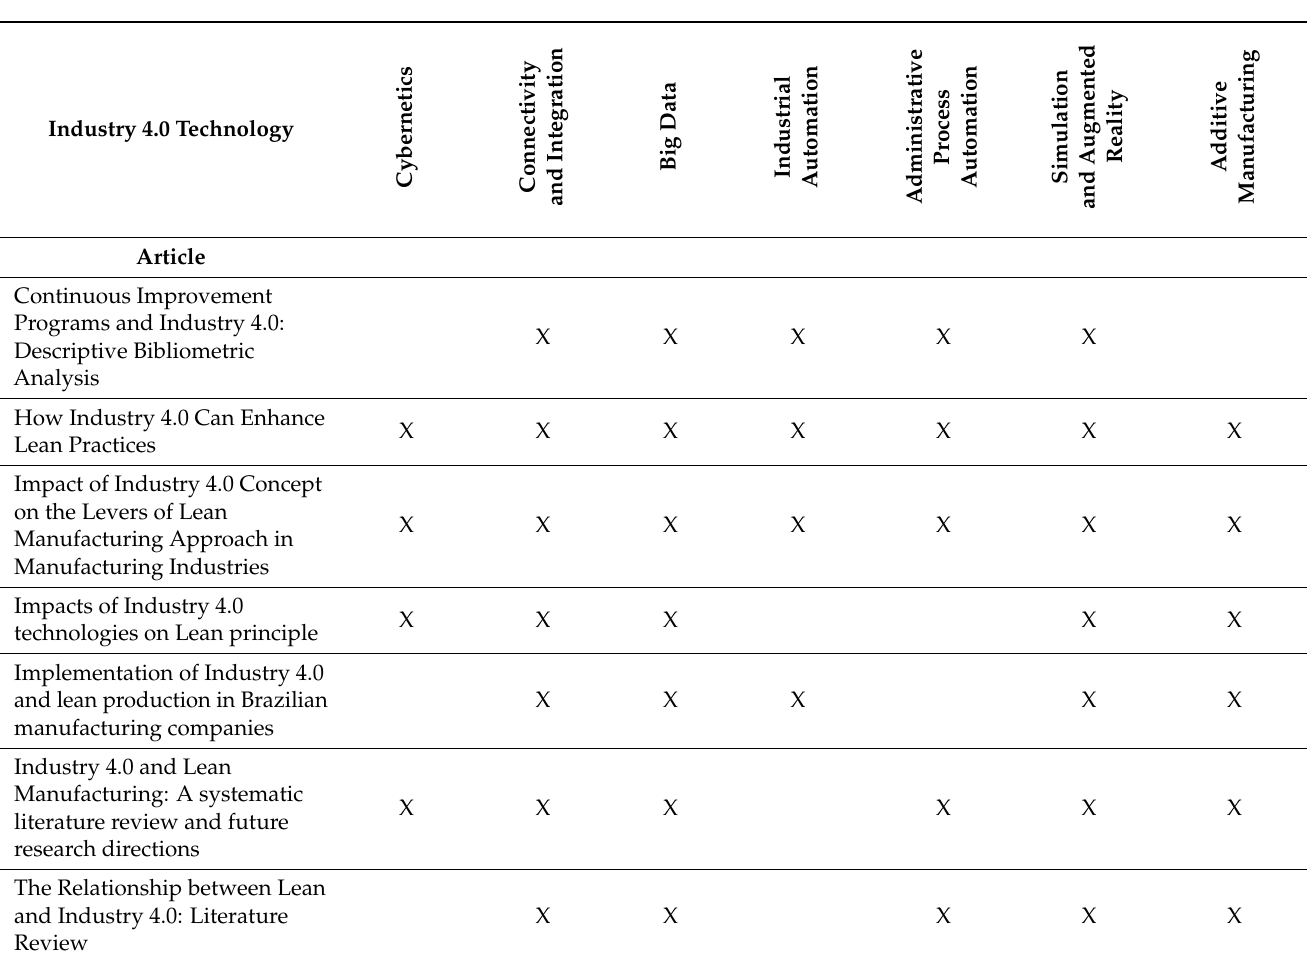
Table 2. Analysis of the article “The integration of technologies Industry 4.0 technology and Lean Manufacturing: A systematic literature review”